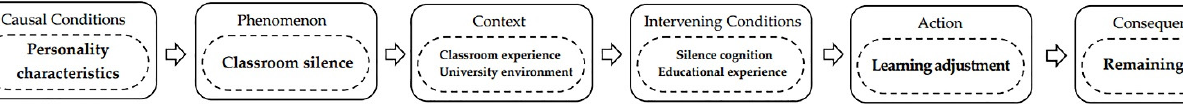
Figure 3. Schematic diagram of the axial coding of Chinese university students’ classroom silence.